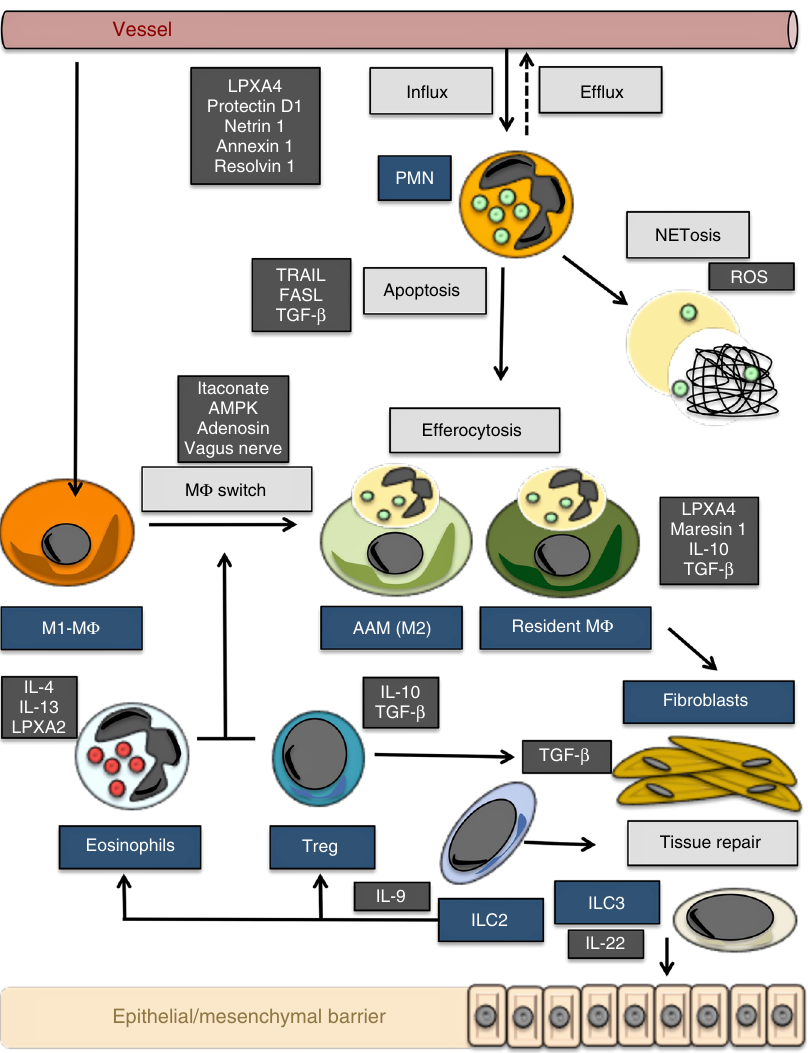
Fig. 2 Functional resolution map. Map of resolution with key mechanisms (bright gray squares), cells (blue squares), and molecules (dark gray squares). AAM alternatively activated macrophage, AMPK adenosine monophosphate-activated protein kinase, ILC innate lymphoid cells, IL interleukin, LPX lipoxin, M Φ macrophages, PMN polymorphonuclear neutrophils, TGF transforming growth factor, TRAIL tumor necrosis factor-related apoptosis inducing ligand, FASL Fas ligand, ROS reactive oxygen